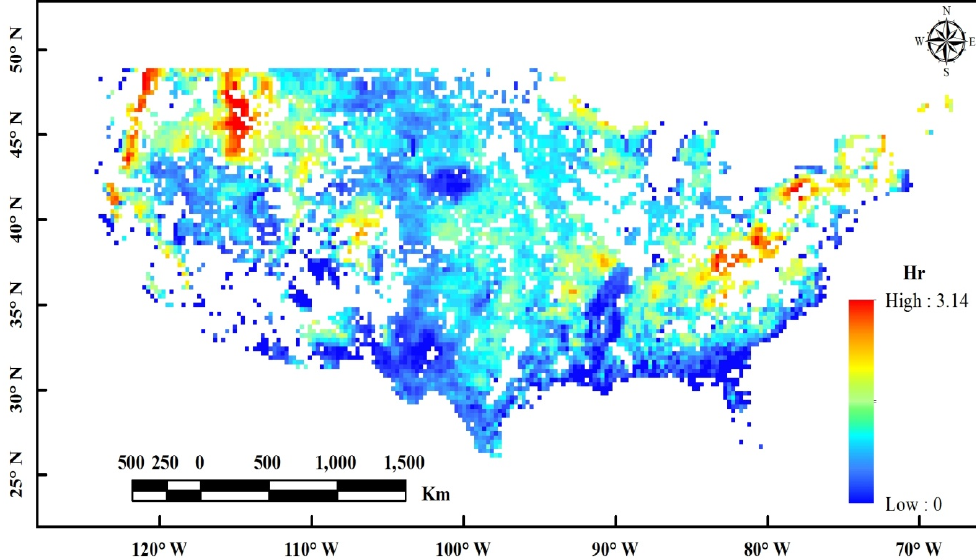
Figure 6. Global map of the retrieved roughness parameter (cid:1834)(cid:1870) at C-band